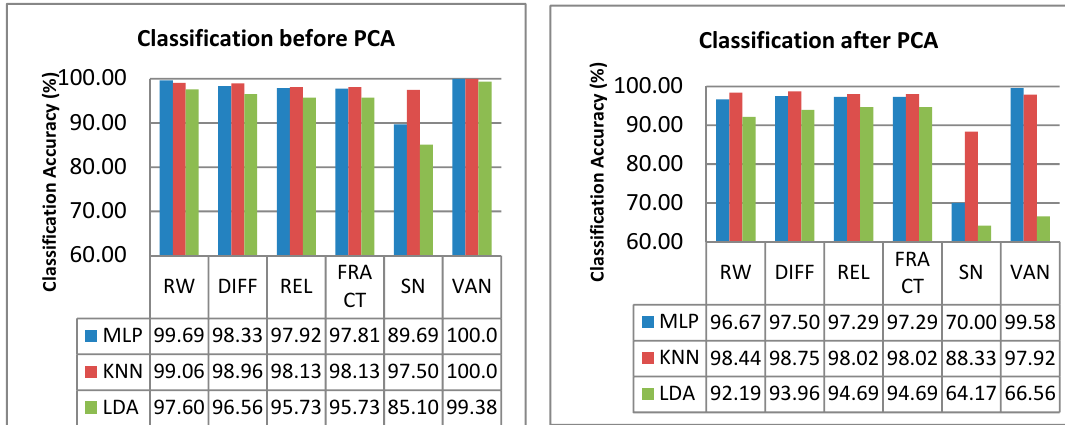
Figure 8. Classification performance for the before- principal component analysis (PCA) and after- principal component analysis (PCA) dataset.